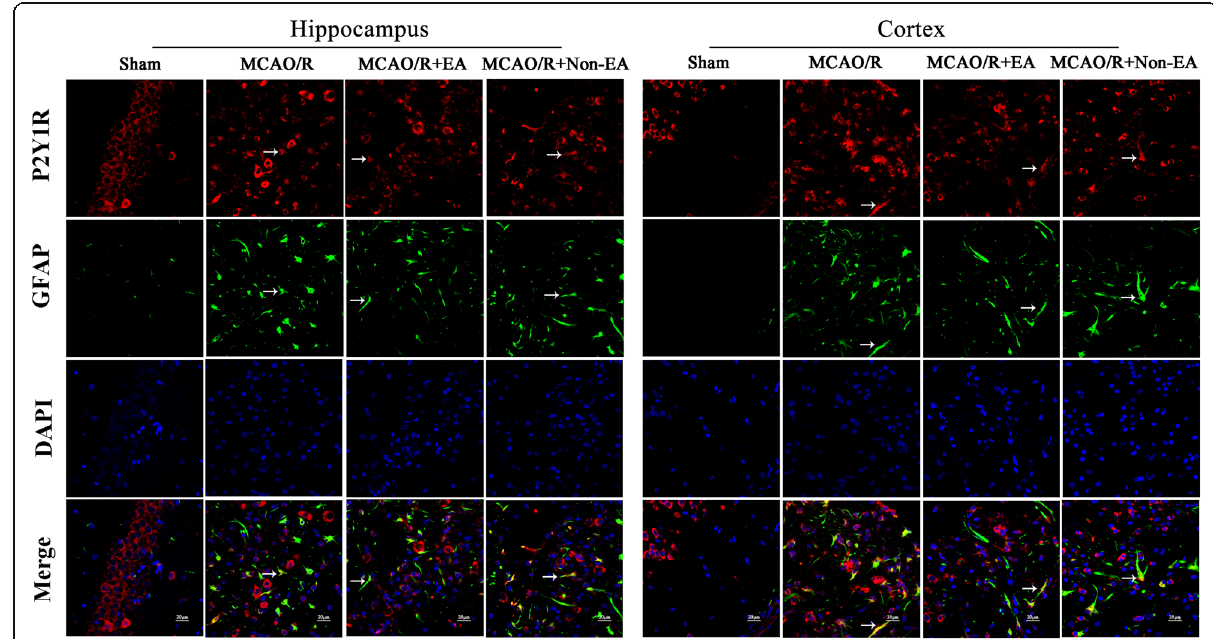
Fig. 9 Effects of EA on P2Y1R and GFAP co-expression after MCAO/R injury. The co-expression of P2Y1R and GFAP was examined in the hippocampal CA1 and sensorimotor cortex at Day 7 after EA. P2Y1R-positive cells are green. GFAP-positive cells are red. P2Y1R and GFAP double-positive cells are yellow. The arrows indicate the co-expression of P2Y1R and GFAP. Nuclei counterstained with DAPI (blue). Scale bar 20 μ m